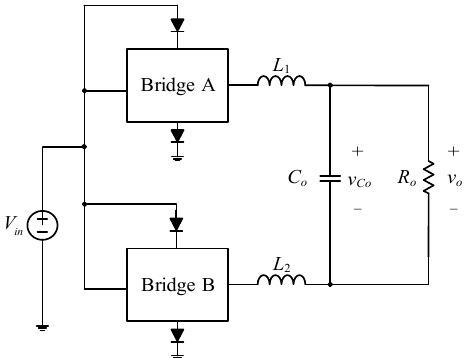
Figure 14. Filter circuit diagram for the output load.